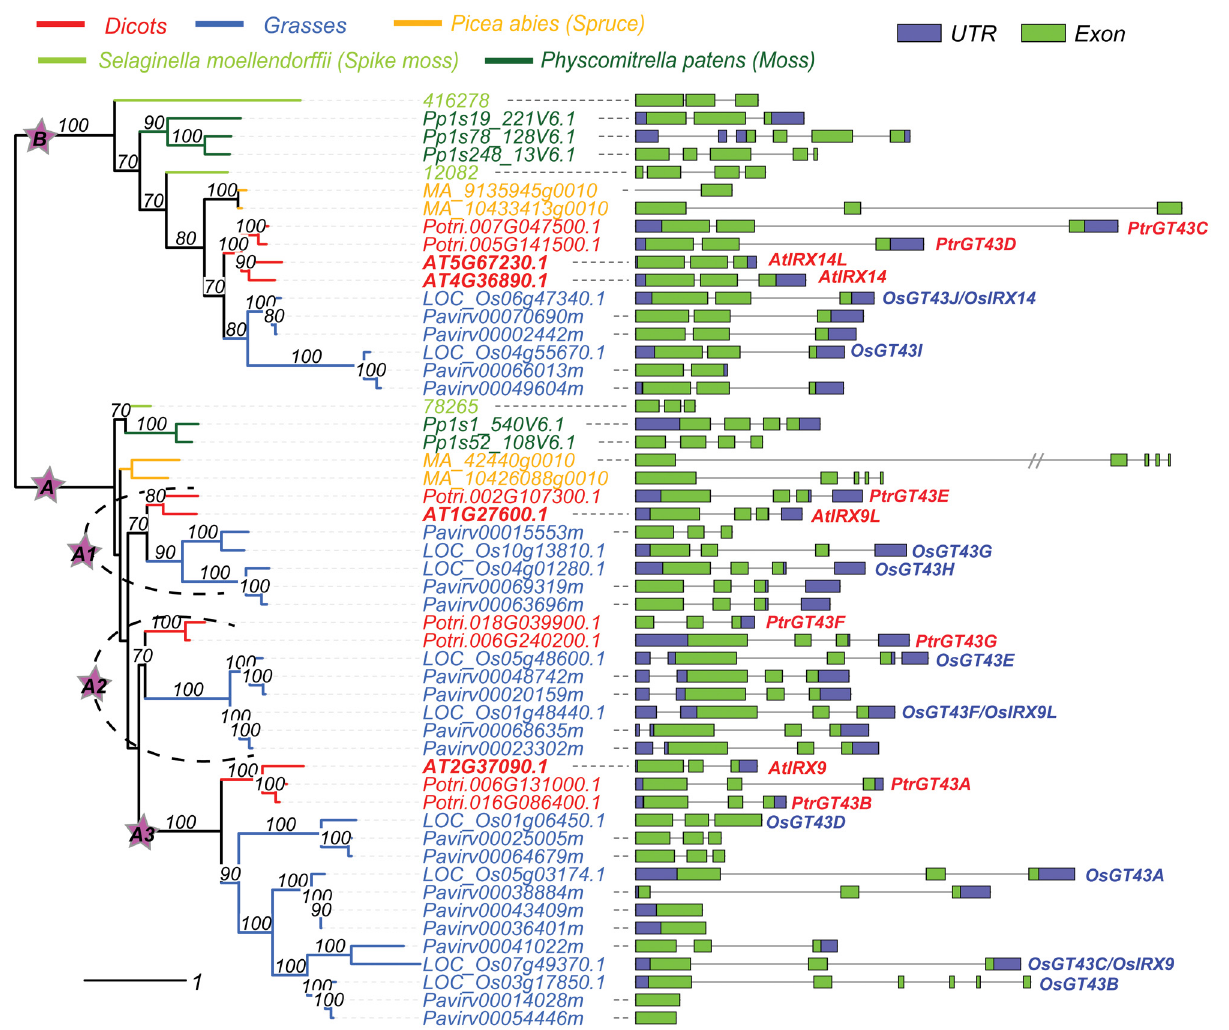
Fig 3. Intron-exon structures of plant GT43 genes. 52 proteins were used to build the phylogeny using RAxML program (see Methods). Gene structures were plotted on the right using the GSDS server [46]. All the protein IDs can be searched at Phytozome [34]. Poplar gene names (e.g. PtrGT43A) were adopted from [47] and rice gene names (e.g. OsGT43A) were adopted from